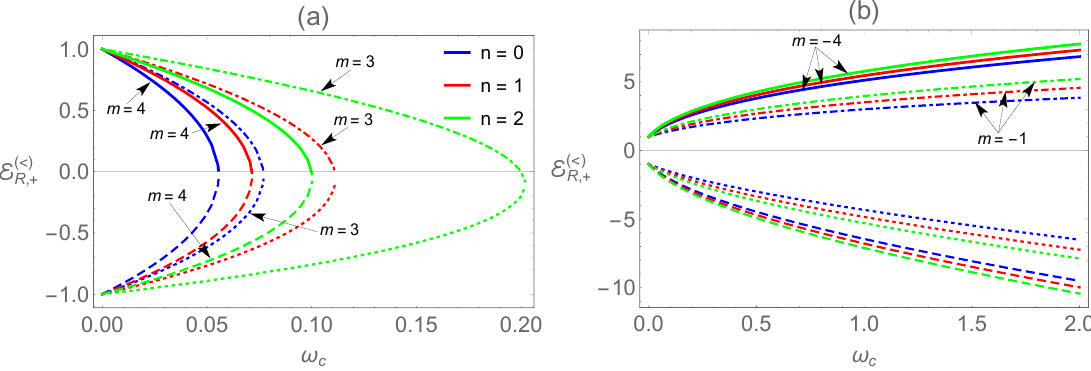
( < ) (Equation (71)) as a function of ω c . In ( a ), a = 0.2, α = 0.8, R , +